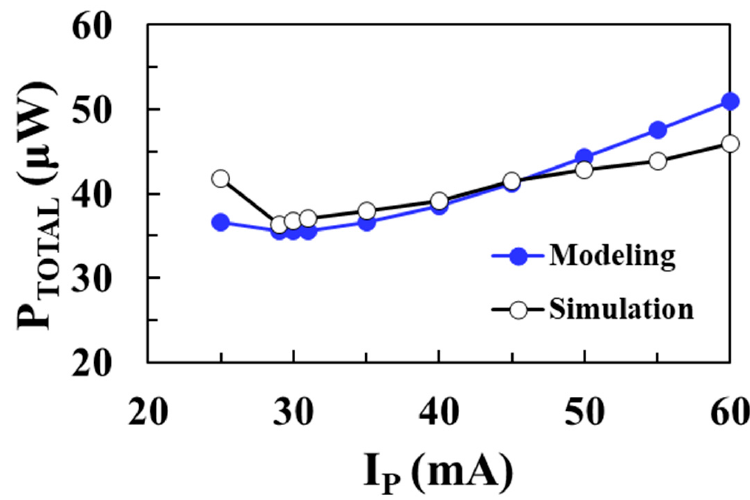
Figure 17. Total loss according to the peak inductor current for an input voltage of 0.1 V and comparison with the modeling results.